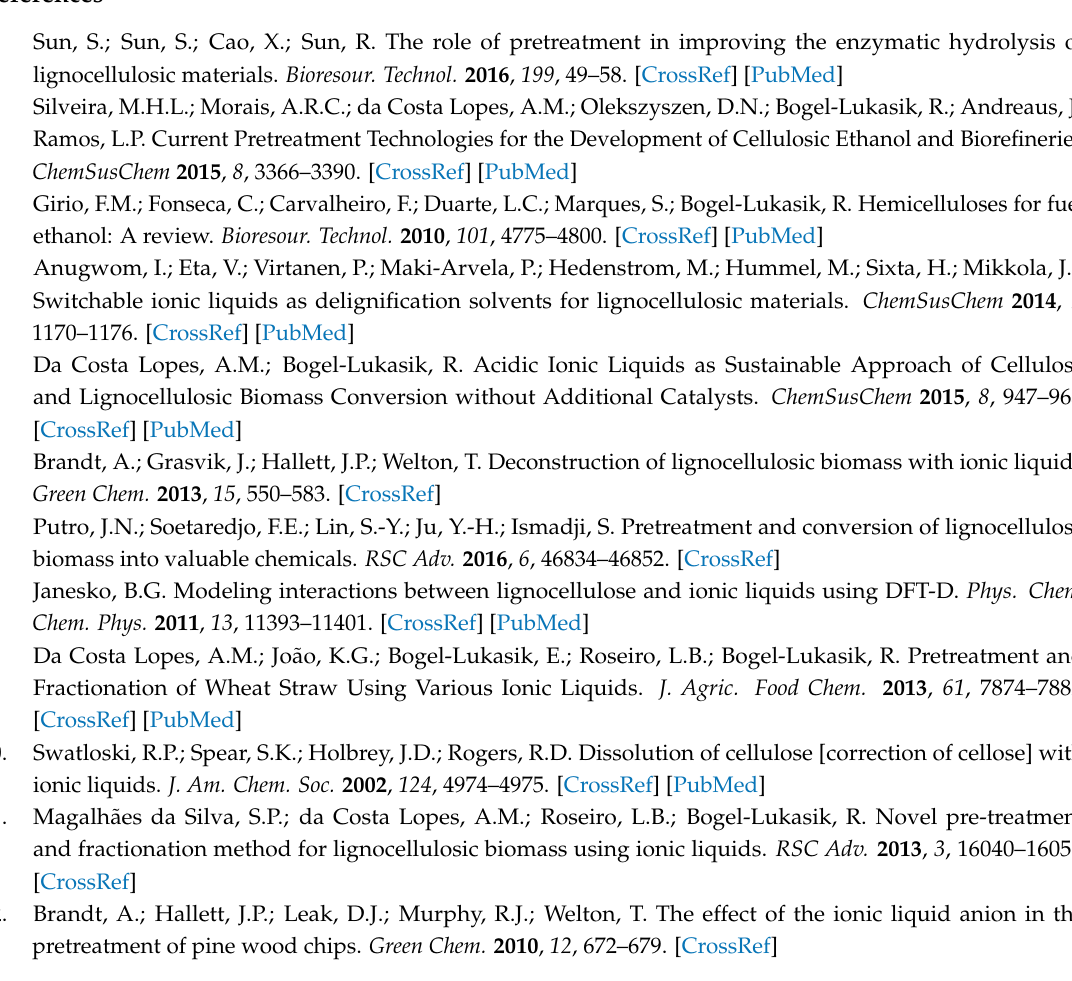
Supplementary Materials: The following are available online: Table S1. Composition of cellulose- and hemicellulose-rich fractions obtained from wheat straw pre-treated with [emim][OAc] at 120 and 140 ◦ C and 2 h; Table S2. Composition of cellulose-rich fractions obtained from eucalyptus pre-treated with [emim][OAc] at 120 and 140 ◦ C and 2